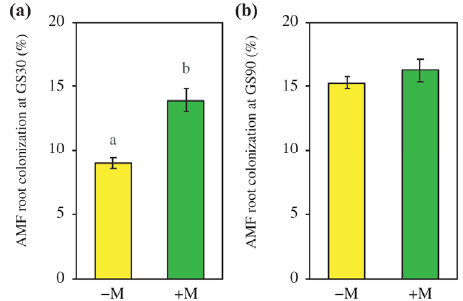
Figure 1. Effect of AMF inoculation on AMF root colonization at GS30 ( a ) and at GS90 ( b ). AMF inoculation and mock control are indicated as +M and − M, respectively.